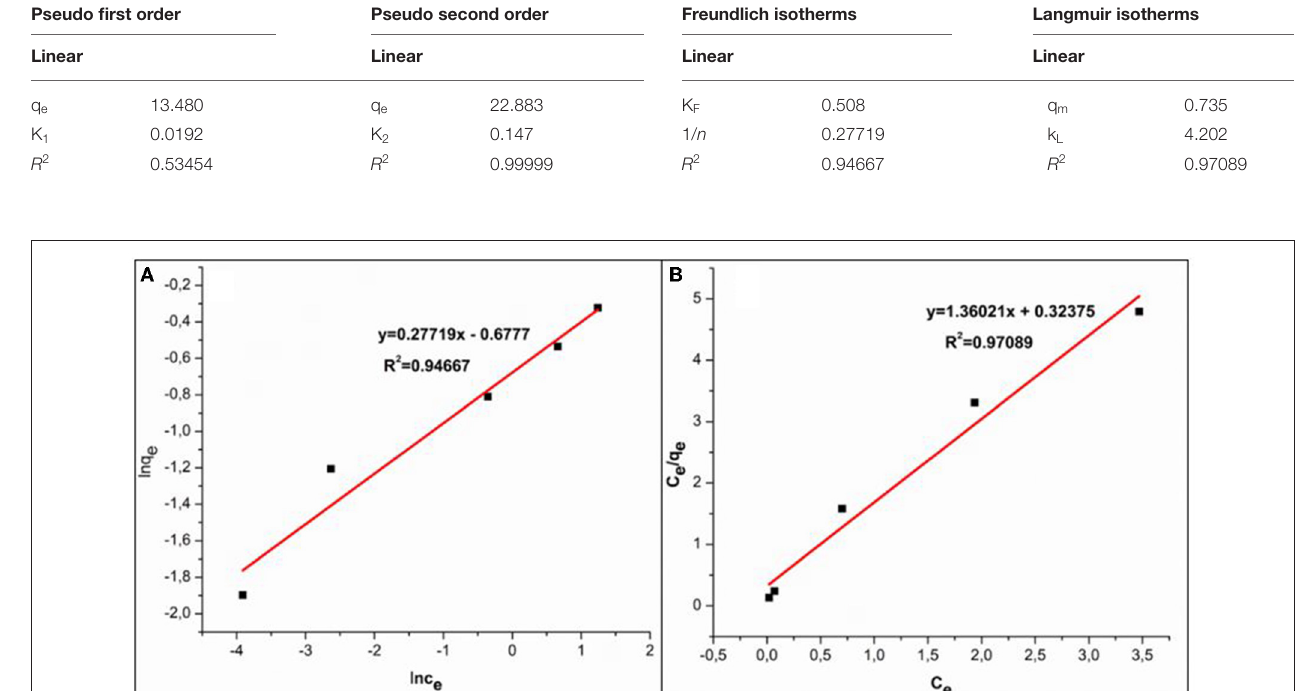
TABLE 1 | Data for Pseudo first order and Pseudo second order. Pseudo first order